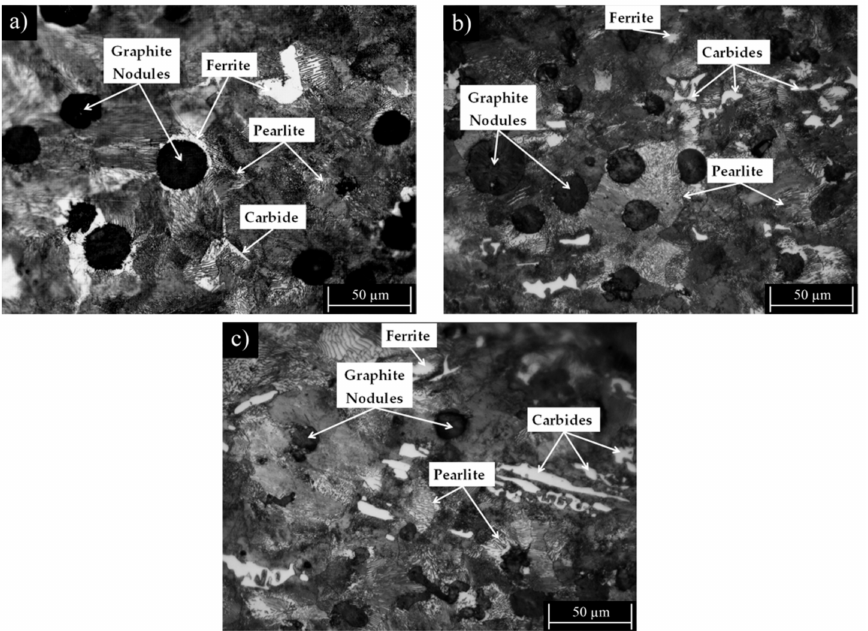
Figure A5. Etched microstructure at high magnifications for the ( a ) unalloyed ductile iron, ( b ) ductile iron alloyed with 0.2 wt % V, and ( c ) ductile iron alloyed with 0.3 wt % V for different the middle zone of the lobes.